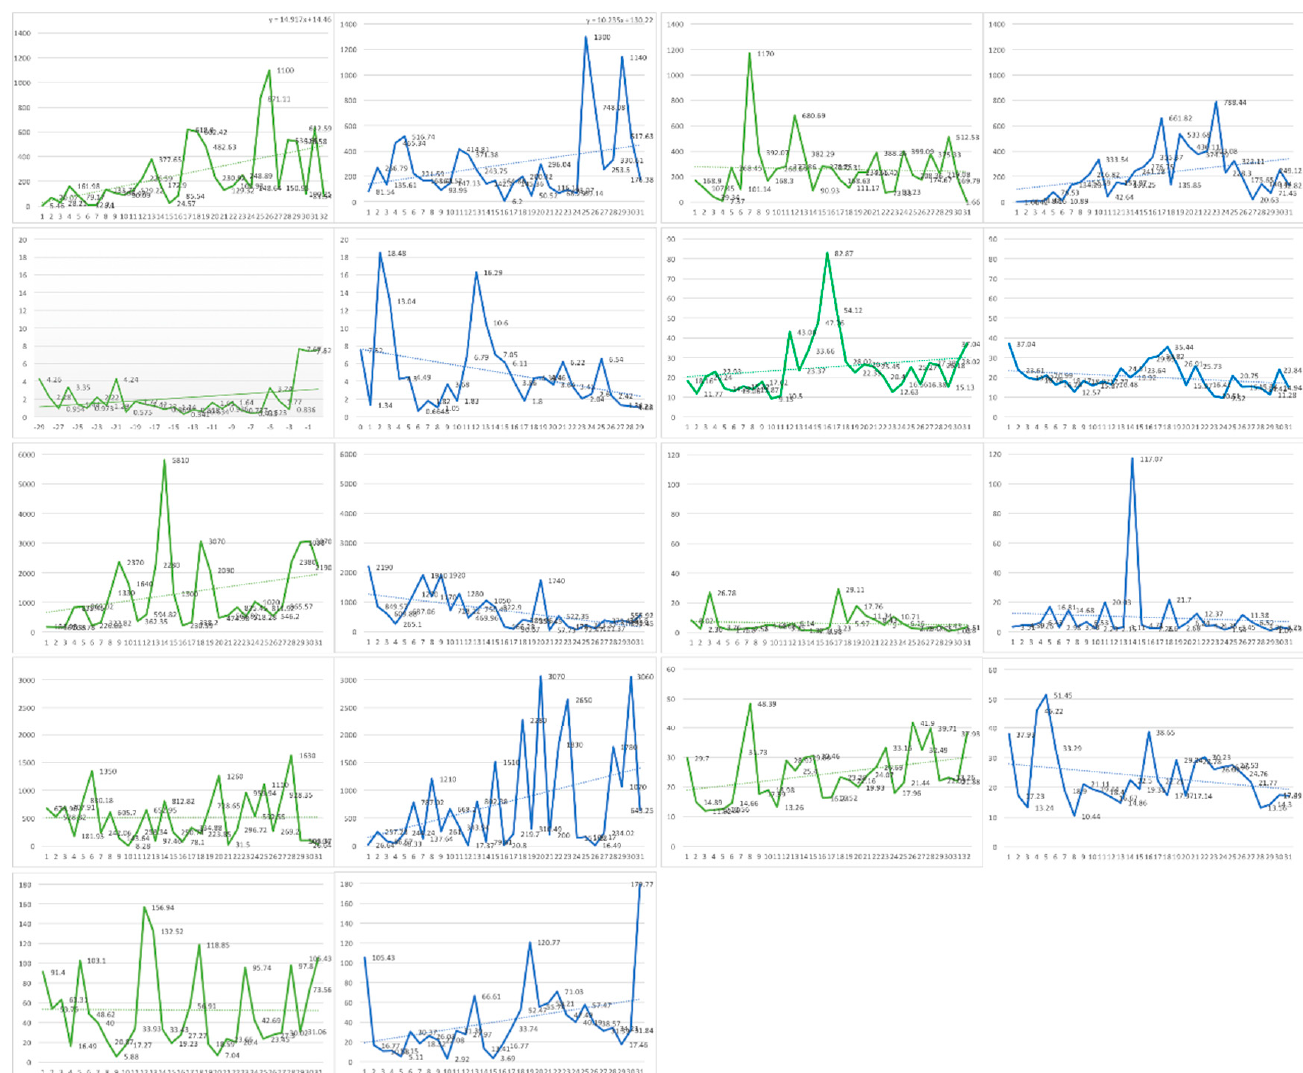
Figure 3. Daily trading volume over 30 days before and after the split date for nine samples, from sample 1 to sample 9, from left to right, top to bottom. Each left panel (green line online) represents the daily trading volume starting 30 days before the split. Each right panel (blue line online) represents the daily trading volume up to 30 days after the split. A linear fit is reported in order to suggest the trend behaviour; see also Figure